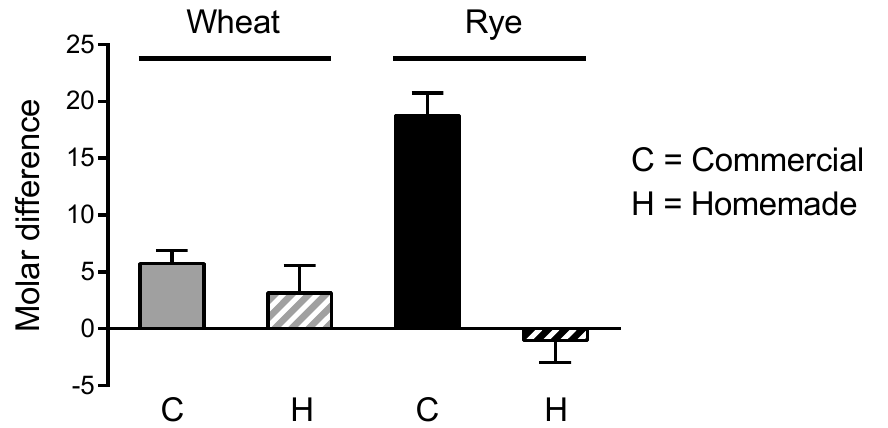
Figure 3. Crust vs. crumb: comparison of moles of itaconate isomers in crust gained vs. moles of cis -aconitate in crust lost. The difference in cis -aconitate concentration (moles/mg dry weight) between crust and crumb was subtracted from the difference in concentration of itaconate isomers (sum of the 3 isomers) between crust and crumb. A positive value indicates that the gain in itaconate isomers concentration is larger than the loss of cis -aconitate concentration. Based on the same data underlying Figure 2.